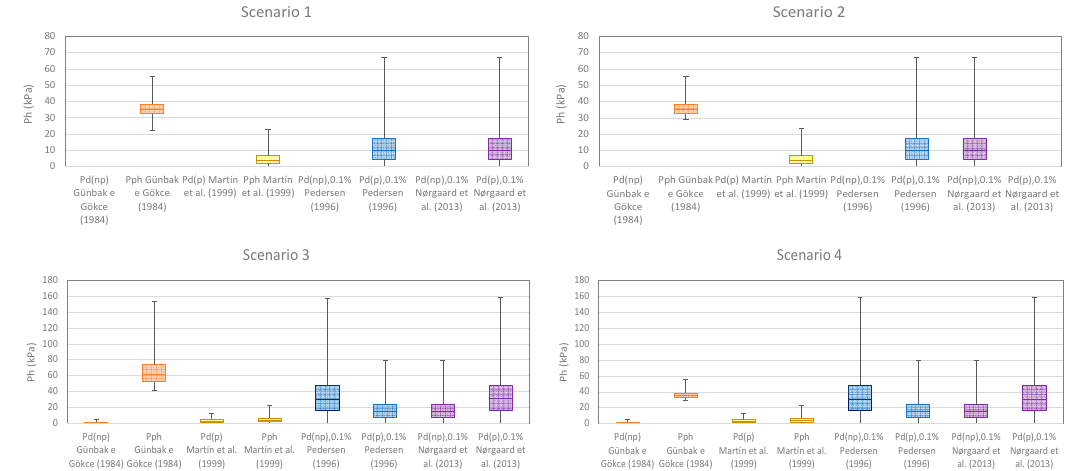
Figure 21. Results of P h for the different formulas for Scenario 1 to 4.